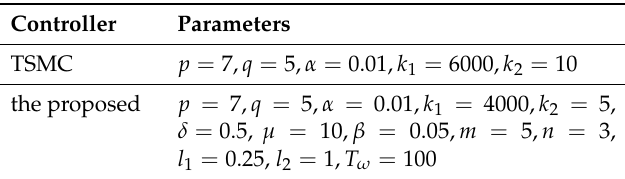
Table 2. Simulation parameters of different control